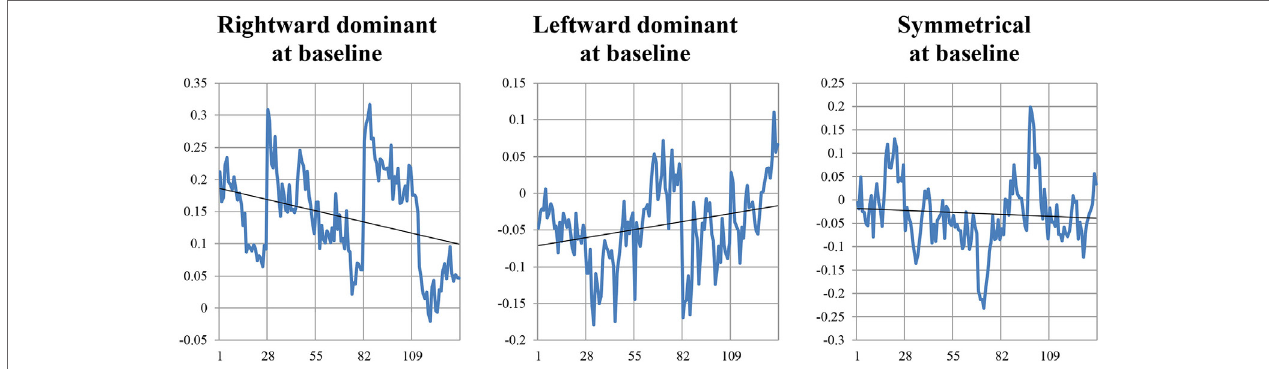
FigUre 6 | Temporal lobe high frequency asymmetry scores during the initial five HIRREM sessions. Vertical axes indicate values for asymmetry scores calculated from serial 15-s epochs (27 per session), from the first 7 min of a temporal lobe exercise conducted during that session. Gridlines along horizontal axis indicate the start of each